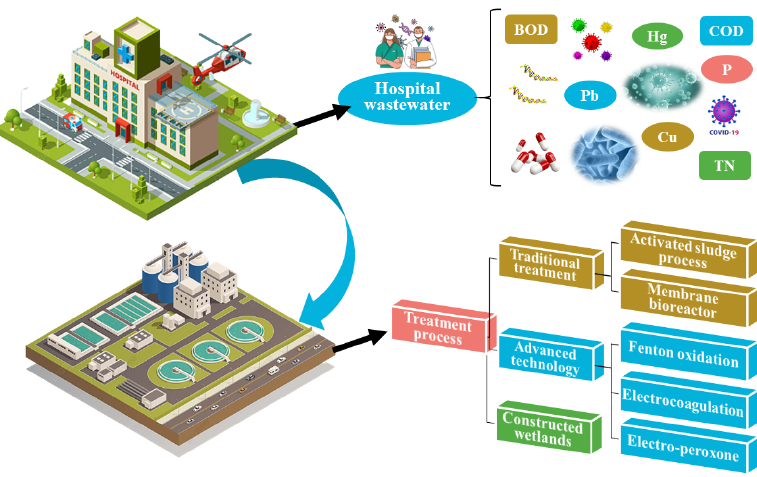
Figure 1. A schematic summary of hospital wastewater and its treatment processes.